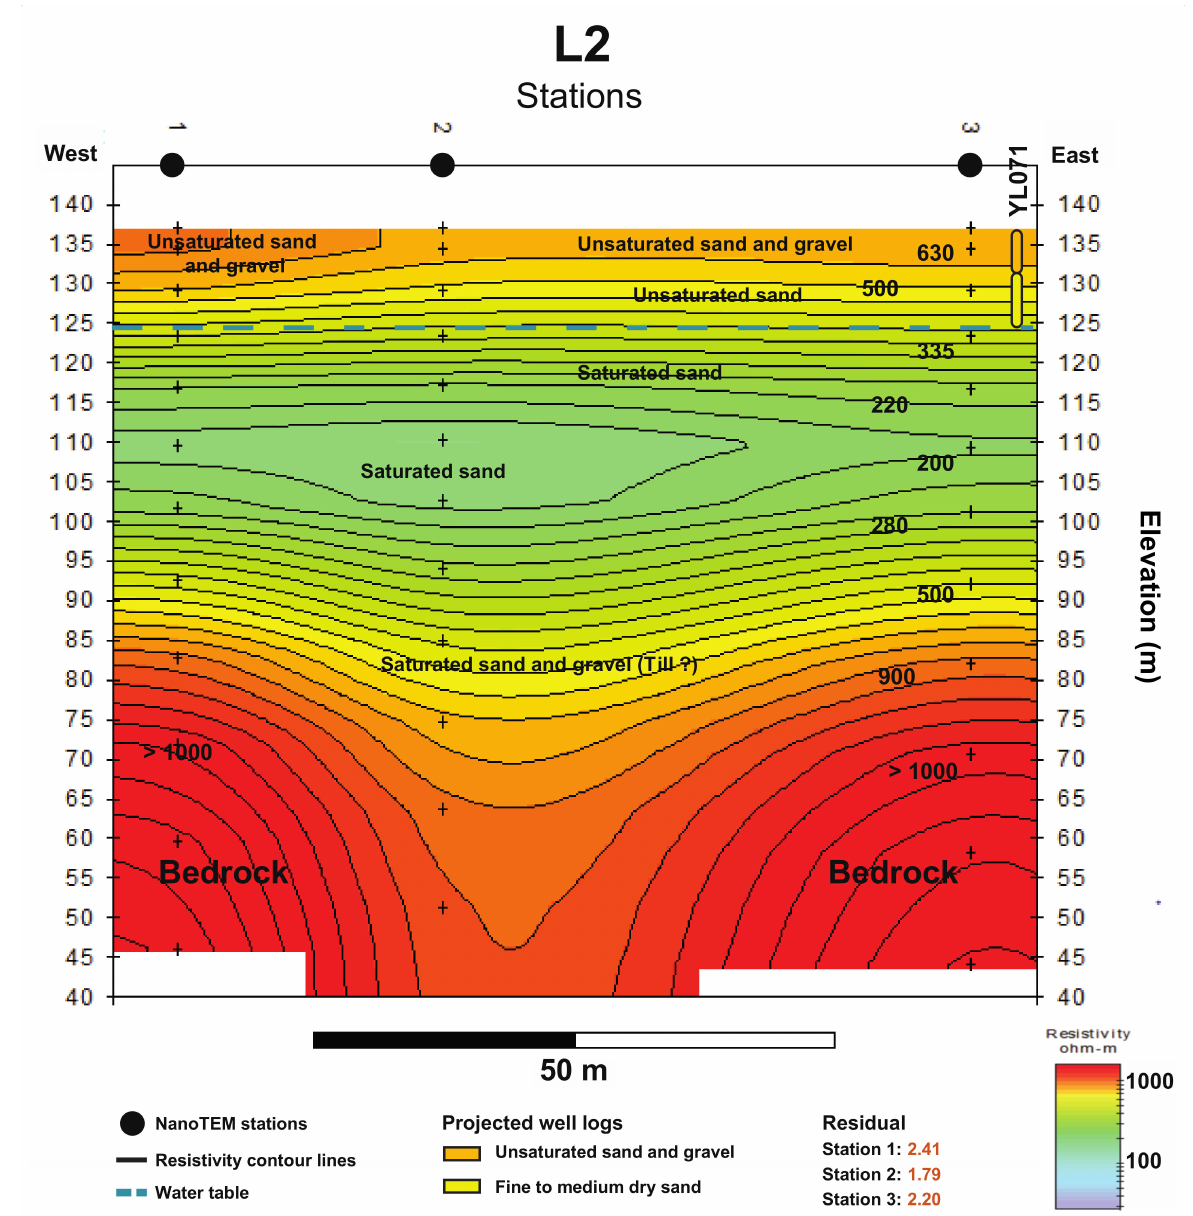
Figure 4. The interpreted 2D Section L2 and stratigraphic cross-section YL071 taken near Notre-Dame-du-Mont-Carmel, Quebec. The surface deposit elevation is obtained from lidar data. The blue dashed line represents the projected water table from direct observations in the field. The legend indicates only those sediments observed directly in the area (YL071). If no boreholes (or stratigraphic cross-sections) were acquired, the subsurface information is deduced from the calibration